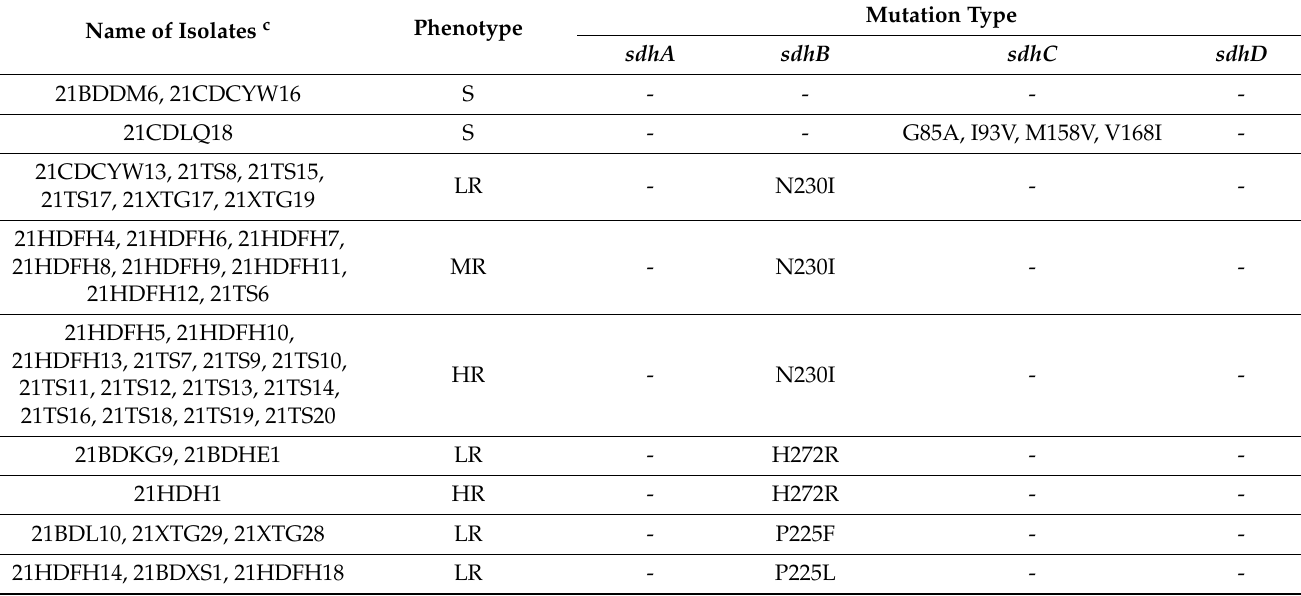
c : The 40 isolates sampled from tomato plants affected by gray mold and treated with SDHI fungicides cropped in Hebei Province (China), in 2021 and 2022. For the gene sdhC , four concurrent mutations were only observed in the sensitive isolate 21CDLQ18 (Figure S2); the mutants with glycine changed to alanine at position 85 (G85A), isoleucine changed to valine at position 93 (I93V), methionine to valine at position 158 (M158V) and valine to isoleucine at position 168 (V168I) (Table 4). For sdhA and sdhD genes, no mutations were observed in this